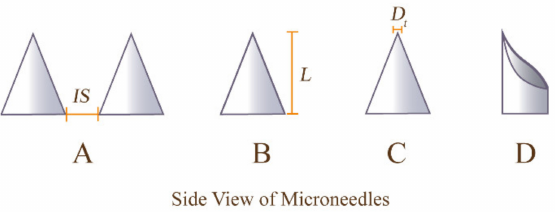
Figure 2. Schematic of MN geometry. ( A ) Edge-to-edge distance of MNs, ( B ) Length of needles, ( C ) Diameter of the tip, ( D ) Shape of